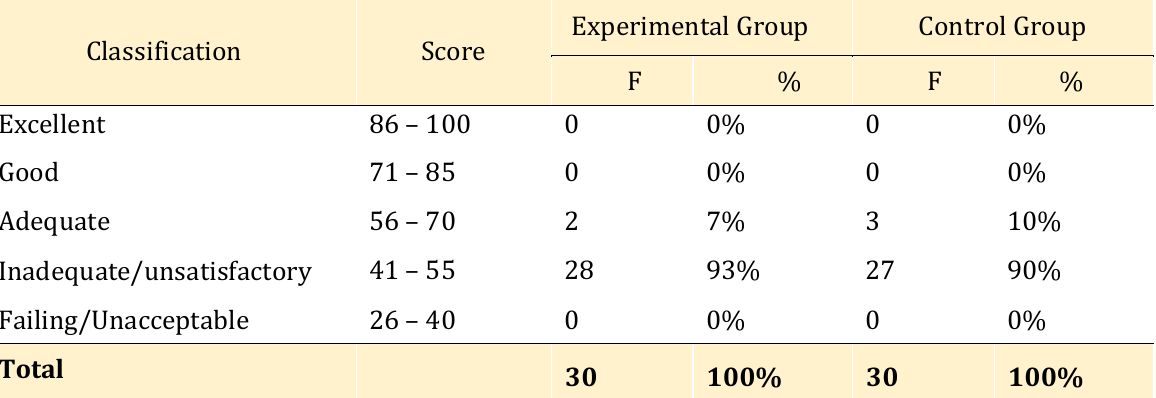
Table 4. The Frequency and Percentage of Students’ Achievement in term of Fluency in Posttest